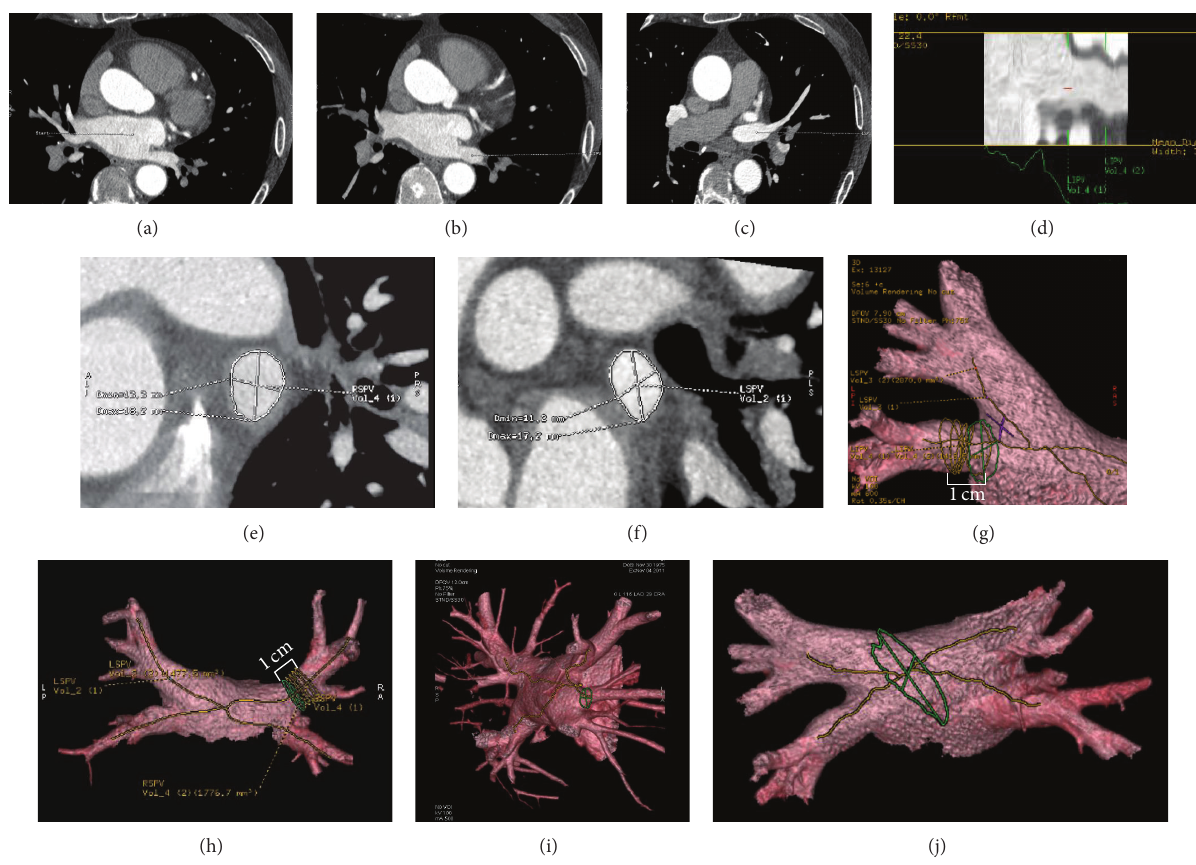
Figure 4: (a–c) Identification and labelling of left atrium and pulmonary vein ostia in 2-dimensional (axial) viewing. (d) Confirmation of point of inflection between pulmonary vein and left atrial wall in curved multiplanar reconstructions. (e-f) Following clear identification of ostia, measurement of minimal and maximal ostial pulmonary vein diameter in oblique view. (g-h) Three-dimensional volume-rendered reconstruction: the previously identified ostium was used as a starting point for volume measurements along the course of the PV to the midpoint of the PV 1cm distal of the ostium. (i) Depiction of pulmonary vein anatomy and branching pattern by using 3D volume- rendered images. (j) Tracing and labelling of left atrium for left atrium volume measurements by using 3D rendered images. LIPV, left inferior pulmonary vein; LSPV, left superior pulmonary vein; RIPV, right inferior pulmonary vein; RSPV, right superior pulmonary vein; RMPV, right middle pulmonary